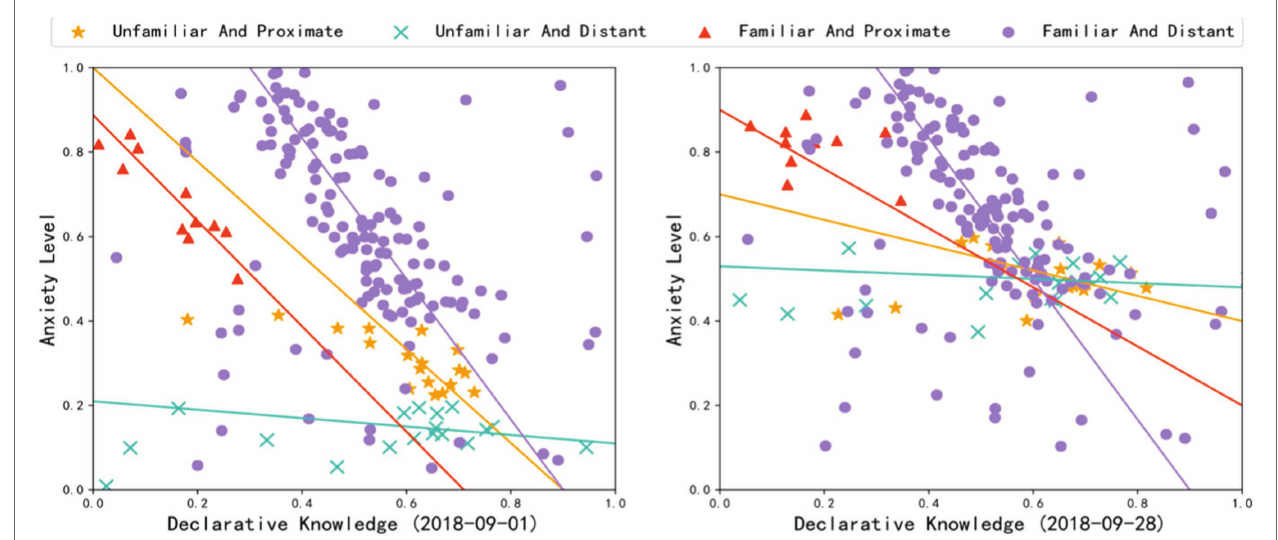
FIGURE 3 | Correlation between declarative knowledge and collective anxiety level (displaying start and end points of our observation time window; other time points showed similar